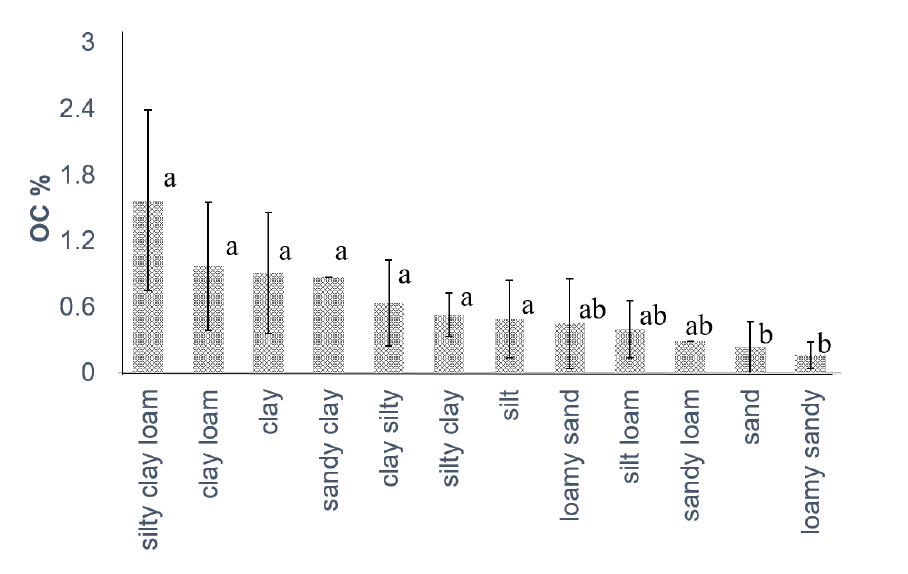
Figure 2. Distribution of soil-organic-carbon (SOC) concentration. Different letters indicate significant differences grouped by soil texture according to the Kruskal–Wallis test, ( p < 0.05).